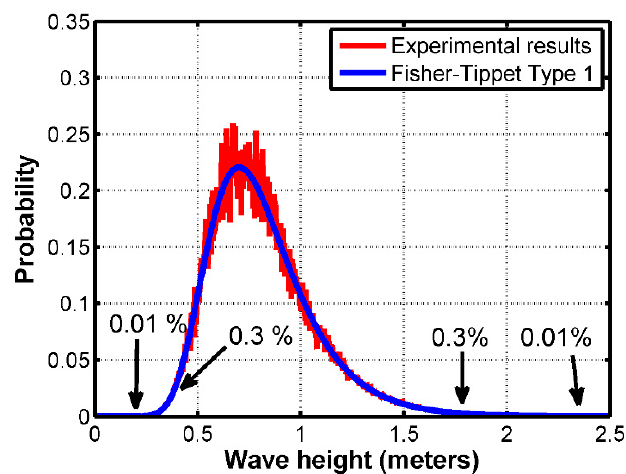
Figure 3. Irregular height wave interactions at the front wall of the chamber. The values for the Fisher-Tippett Type 1 are 𝜇 = 0.7 and 𝜎 = 0.2 .